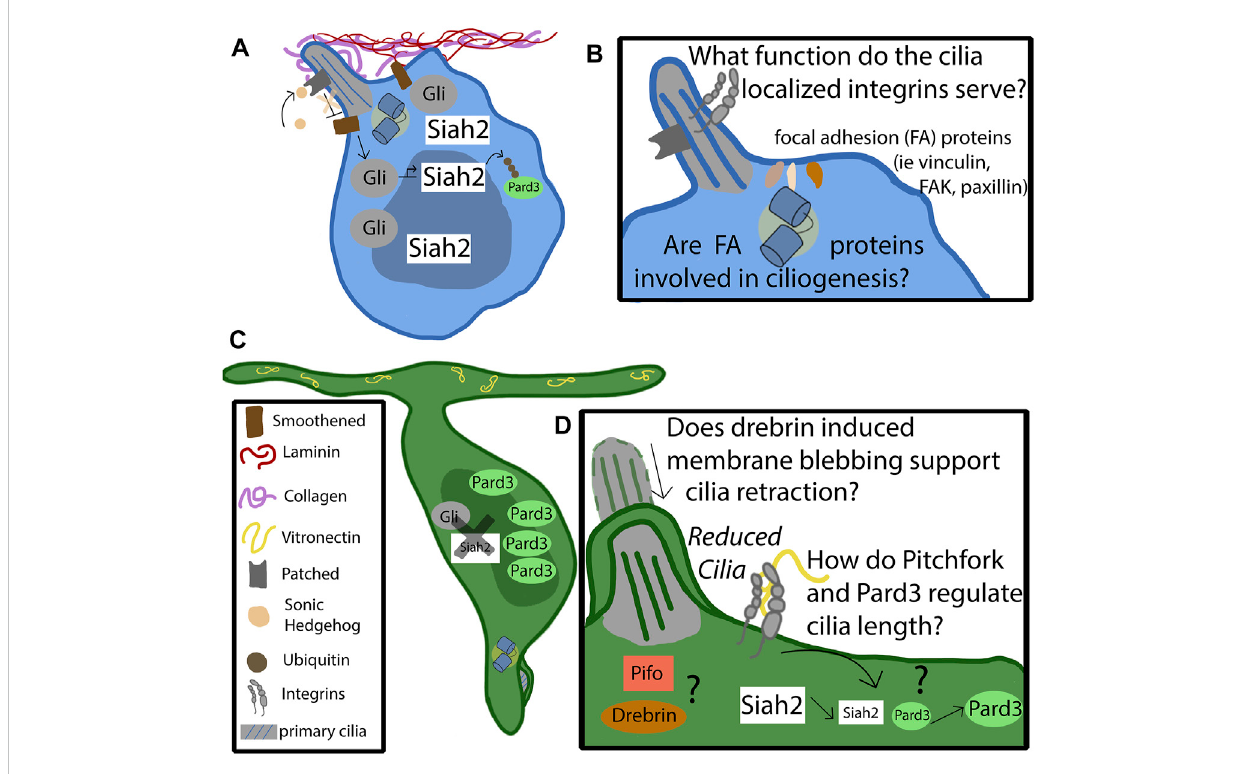
FIGURE 2 Mechanismofcilia-integrincrosstalkinGNPandCGNs. (A) Progenitorcellsremainanchoredinthegerminalzonebyadheringtothelaminincoated basement membrane through focal adhesions enriched in alpha 6 beta 1. The basement membrane consists of collagen, which surrounds the primary cilia, and laminin, which promotes ciliogenesis. The binding of sonic hedgehog to the patched receptor, localized to the primary cilia, relieves the repression of Smoothened (Smo). Activated Smo serves to activate and stabilize the Gli transcription factors, which upregulate the downstream targets of the hedgehog pathway, such as Siah2. Siah2 tags Pard3 with ubiquitin for degradation. Pard3 is part of the polarity complex and is a driver of differentiation. (B) The function of cilia-localized integrins is largely unknown. Do they form canonical focal adhesions, or do they serve as signaling molecules through non-canonical functions? It is known that focal adhesion accessory proteins, such as vinculin, focal adhesion kinase, and paxillin, localizetothebasalbodyatthebaseoftheprimarycilia.Aretheyutilizedbytheprogenitorcelltosupportciliogenesis,ortoassistinproperpositioningof the cilia? (C) At some point the feedback loop that promotes the maintenance of the primary cilia destabilizes. The binding of vitronectin to focal adhesions enriched with alpha V beta three causes, through pathways largely unknown, a decrease in Siah2 expression. As Siah2 expression diminishes, Pard3 expression increases and has the effect of repressing the Shh signaling pathway. Primary ciliogenesis is blocked and the cell differentiates and extends parallel fi bers. (D) The molecular players that cause the cilia to become reduced are largely unknown. Drebrin is known to alter cilia length through membrane blebbing — what role does it play in the granule neuron ’ s cilia maintenance? Does the cell utilize Pitchfork to regulate the cilia length, as is found in other cell